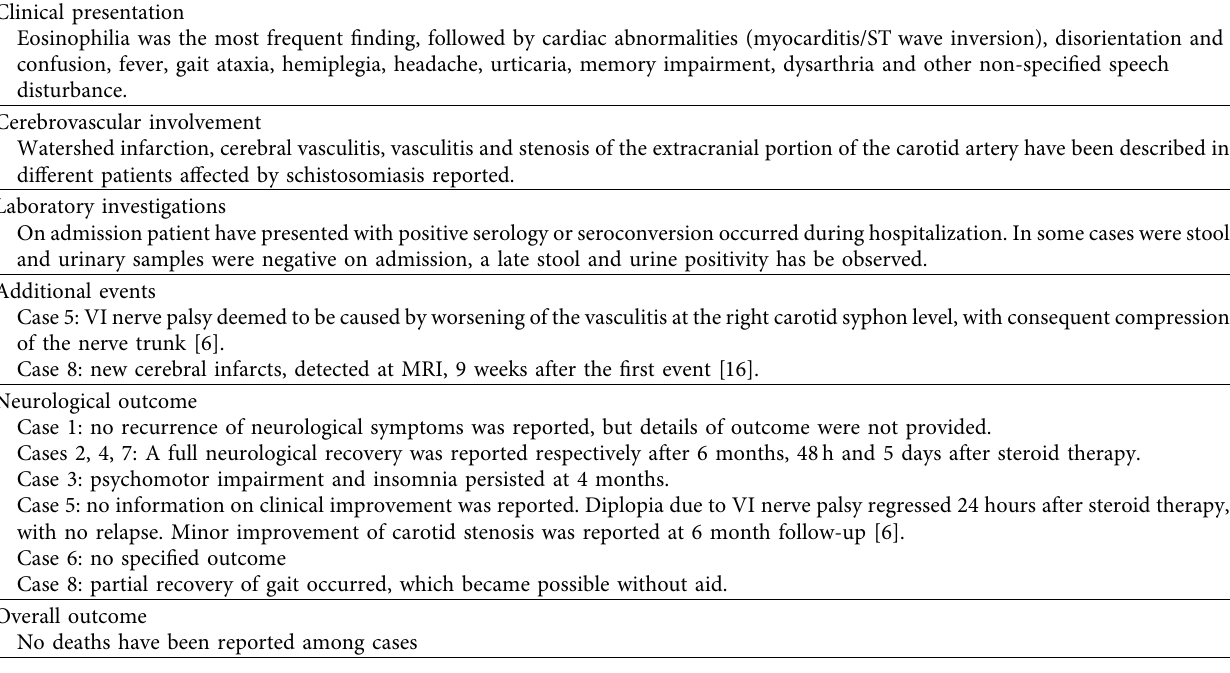
Table 3: Clinical presentation, cerebrovascular involvement, laboratory investigation results, additional events, neurological and overall outcome details in patients with stroke and